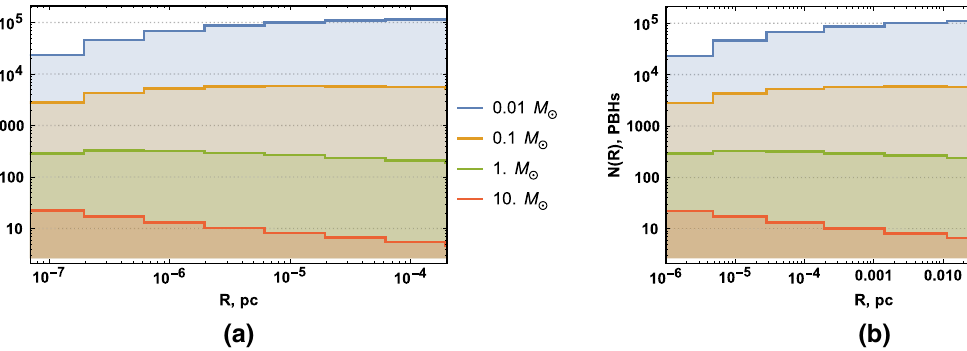
Fig. 3 Spatial distribution inside the cluster. The mass of central PBH is 10 2 M (cid:2) , the selected parameters of the potential: f = 1 . 4 H , (cid:8) = 0 . 05, θ = 0 . 05 π . a The distribution of PBHs inside the cluster just after its formation (after the collapse of all closed walls). b The distri- bution of PBHs just after their detachment from the Universe expansion